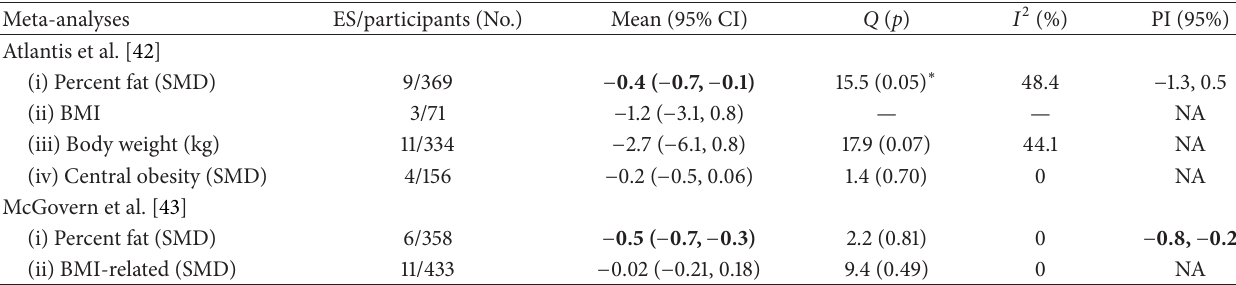
Table 2: Overall findings of included meta-analyses.